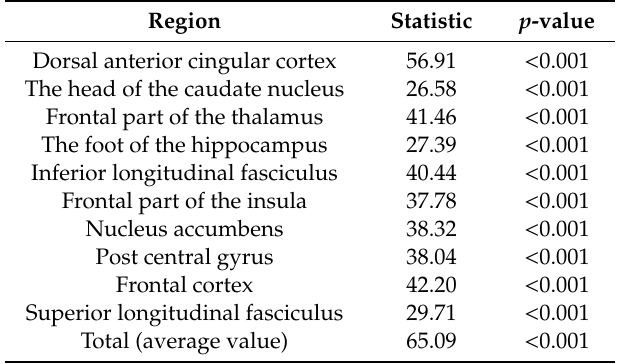
Figure 11. Correlation matrix of Spearman coe ffi cient charts in the superior longitudinal fasciculus region in the alcohol use disorder and control groups. Table 2. Tests for equality of correlation coe ffi cient matrices by Schott